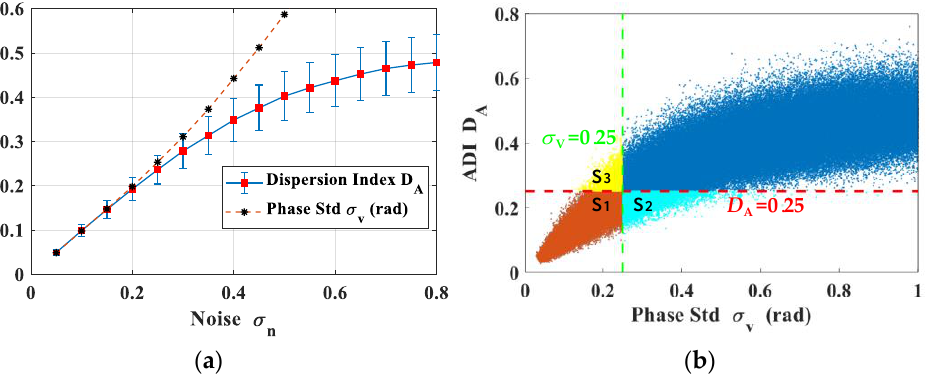
Figure 1. Numerical simulation results. ( a ) Variation curves of the estimated ADI (amplitude dispersion index) D A and phase std σ V with the noise deviation σ n ; ( b ) scatter map of D A with σ V .